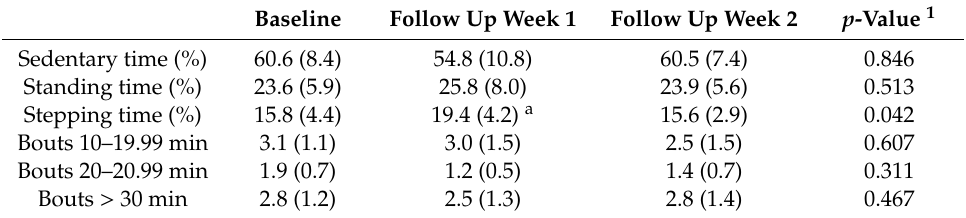
Table 4. Intervention outcomes for the working day (mean ± SD; n =